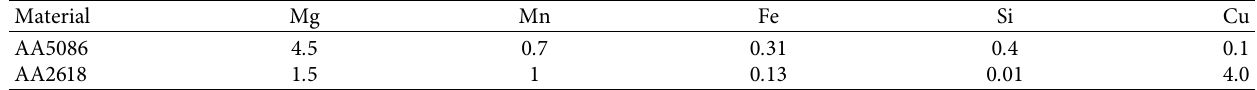
Table 2: The alloys chemical composition (weight